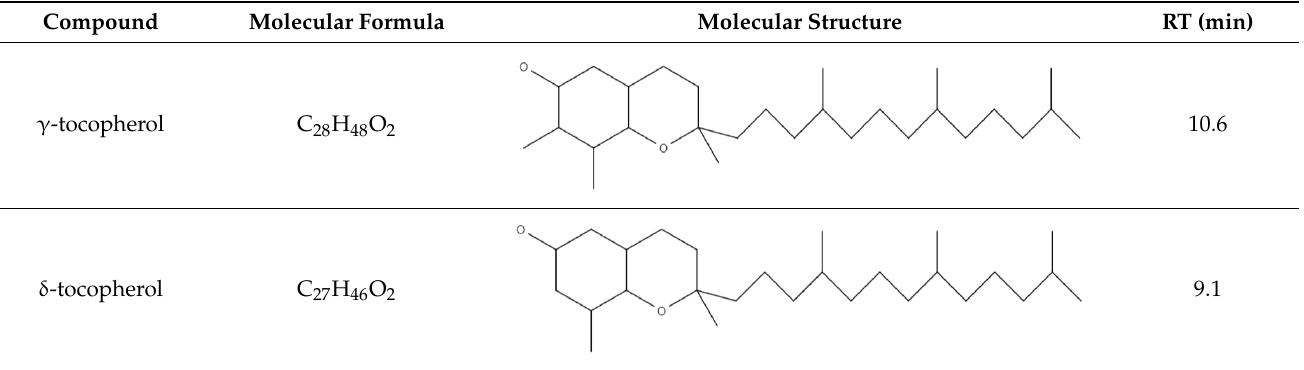
Table 3. Recovery (%R) rates for the evaluation of the reproducibility. Compound